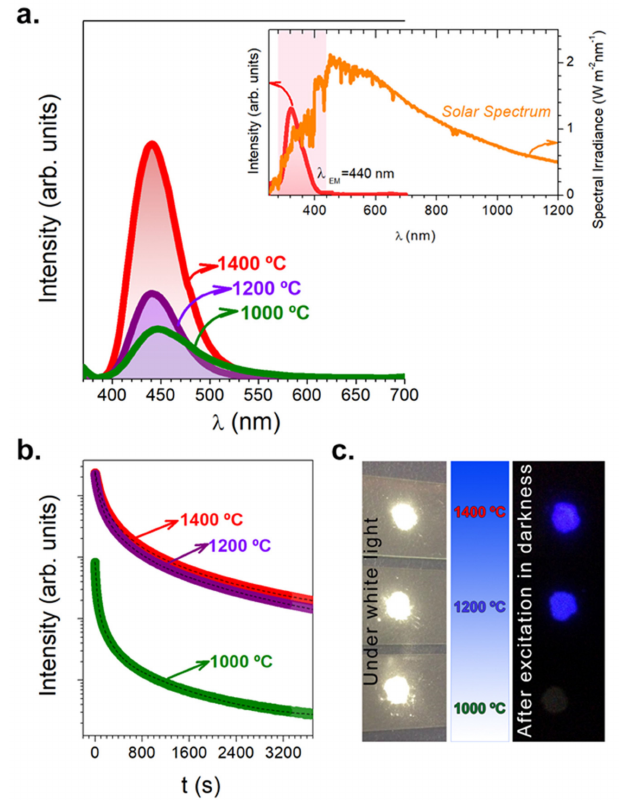
Figure 4. ( a ) Photoluminescence emission spectrum ( λ EXC = 365 nm) of synthesized CAO: Eu, Nd phosphors heated at 1000 (green line), 1200 (purple line), and 1400 ◦ C (red-line) for 2 h in a 90N 2 -10H 2 atmosphere, employing a salt / CAO molar ratio of 3:1. The inset shows the excitation spectrum fixing the emission at 440 nm (red-line) and the standard solar spectrum (American Society for Testing and Materials (ASTM) E-490) (orange line). ( b ) Afterglow decay curves of synthesized CAO: Eu, Nd phosphor heated at 1000 (green line), 1200 (purple line), and 1400 ◦ C (red-line) for 2 h in 90N 2 -10H 2 , employing a salt / CAO molar ratio of 3:1 ( c ) Photographs of the CAO particles under white light excitation (left-image) and in dark after being activated for 10 min by a solar simulator